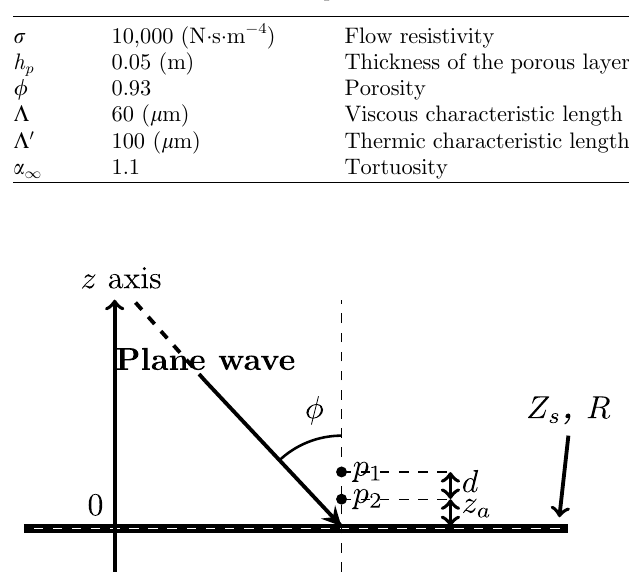
Table 1. JCA model parameters of the polyurethane foam used in numerical simulations and experiments.